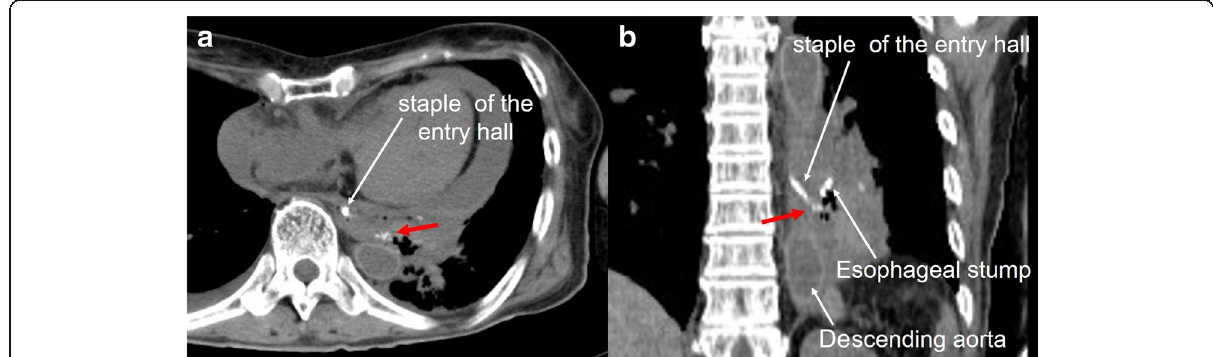
Fig. 3 Post-mortem computed tomography showing that the dorsal stapled edge (red arrow) of the entry hole was in direct contact with the bare descending aorta. a Axial plane. b Coronal